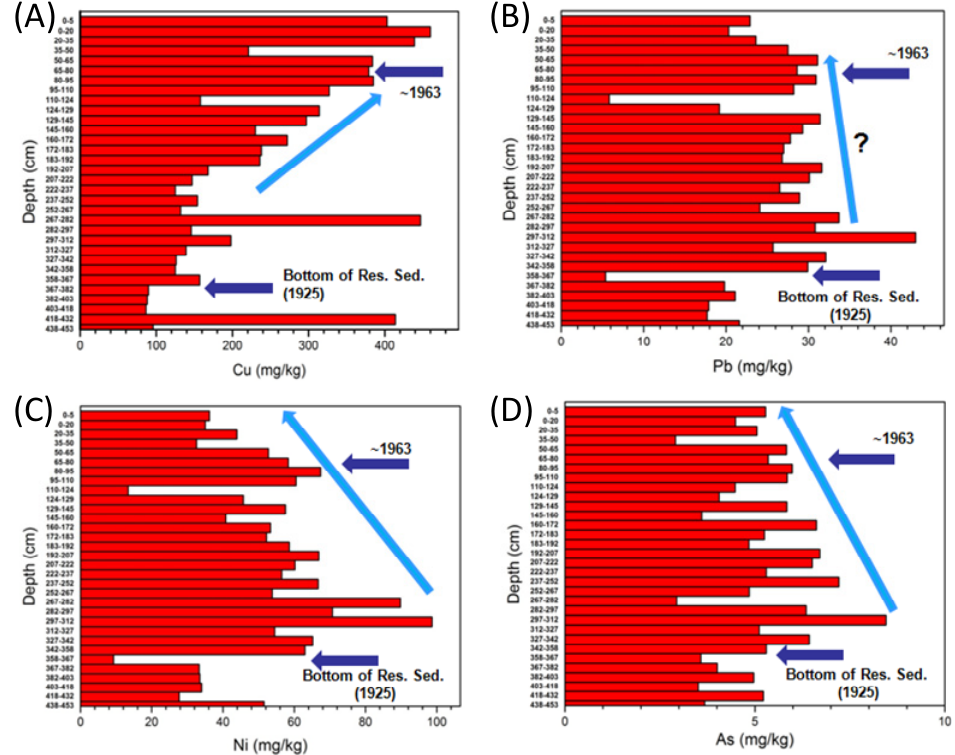
Figure 6. Vertical (depth) variations in Cu ( A ), Pb ( B ), Ni ( C ), and As ( D ) concentrations within samples collected from a sediment core extracted from Lake Emory along the Upper Little Tennessee River, western North Carolina. Pb, Ni, and As concentrations decrease from 1925 to present. High values correlate with the erosion of metal enriched subsoils during land-use change. In contrast, Cu loadings to the river have increased since dam closure in 1925 in response to the use of Cu based pesticides within the watershed (from Miller and Mackin